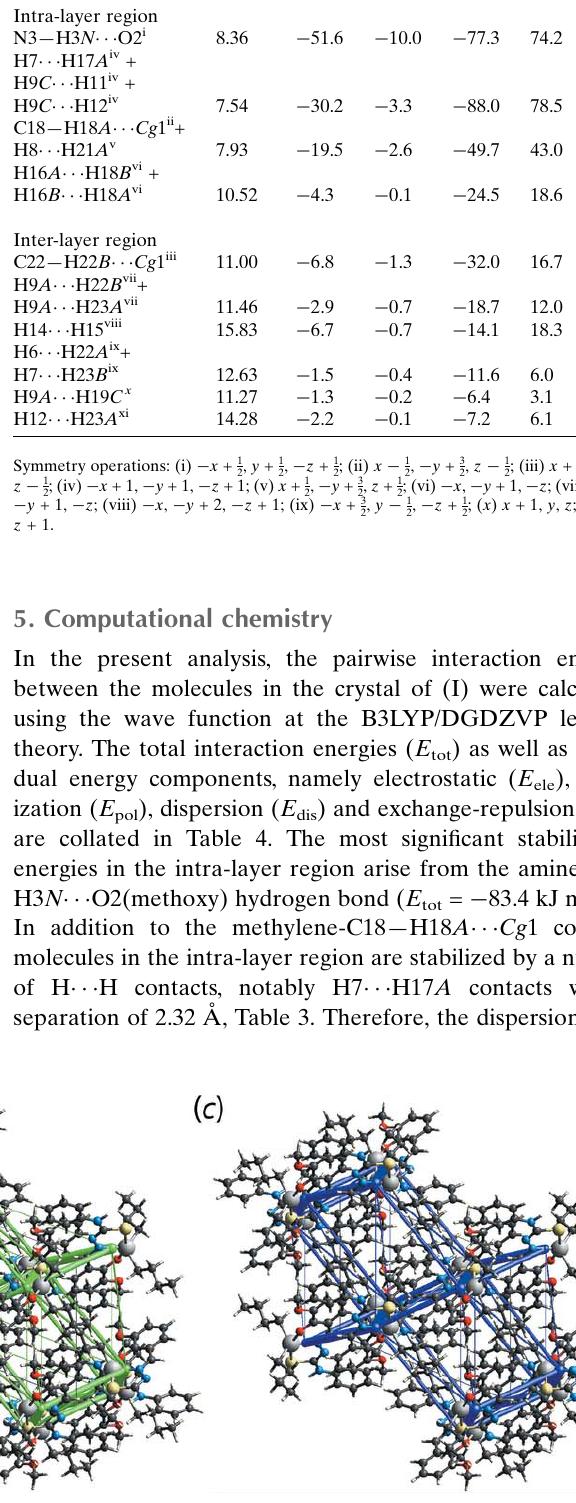
Table 4 A summary of interaction energies (kJ mol (cid:6) 1 ) calculated for (I). Contact